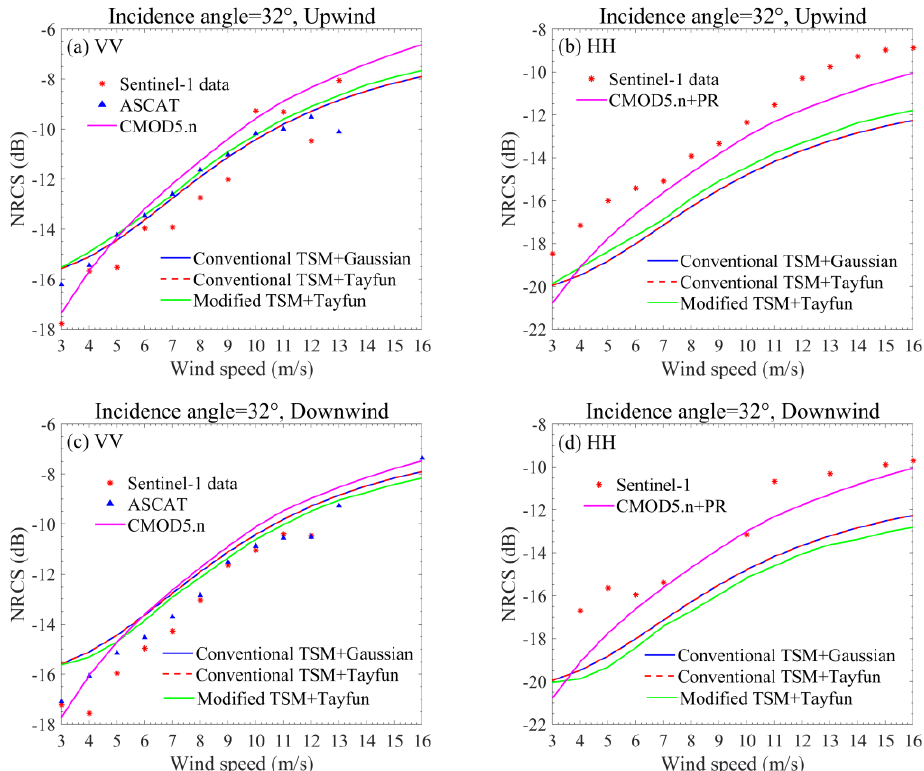
Figure 9. The simulated average NRCSs based on conventional TSM + Gaussian sea surface, con- ventional TSM + Tayfun sea surface, and modified TSM + Tayfun sea surface and their comparison with the reference data at a 32° incidence angle as functions of the wind speed ( a , b ) in the upwind direction under VV and HH polarizations and ( c , d ) in the downwind direction under VV and HH polarizations. Curves and symbols are the same as those in Figure 8.